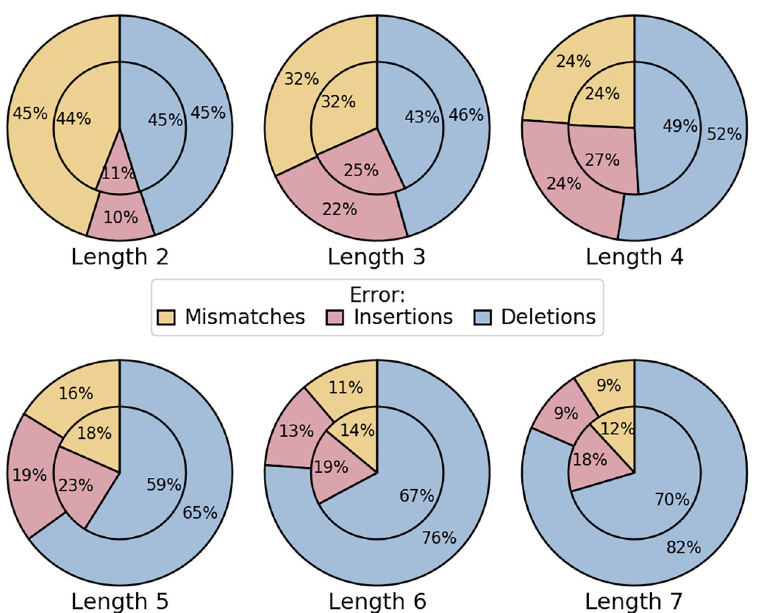
Fig 10. Error rate ratios by type in homopolymers of various lengths. For each length, the error ratios for each type (mismatches, insertions and deletions) are shown, for both bacterial (outside pie) and human (inside pie) datasets.